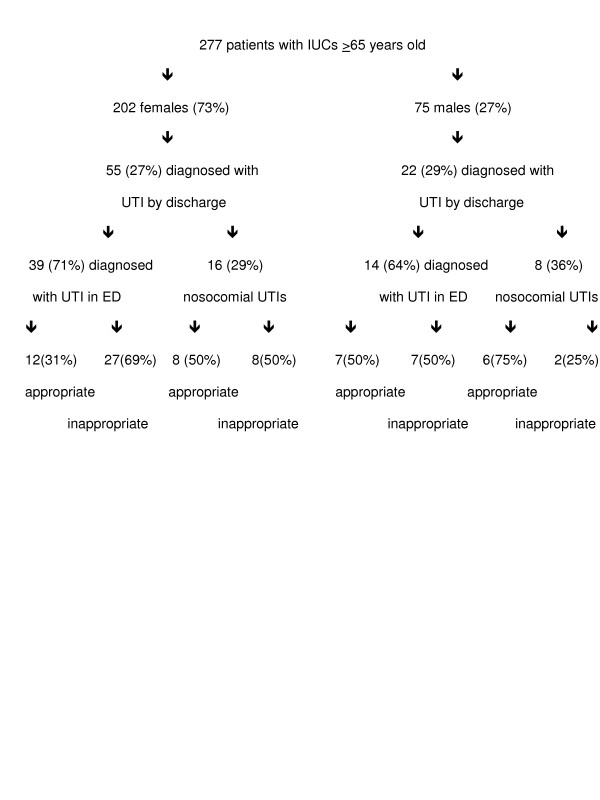
Gender differences in IUC outcomes.